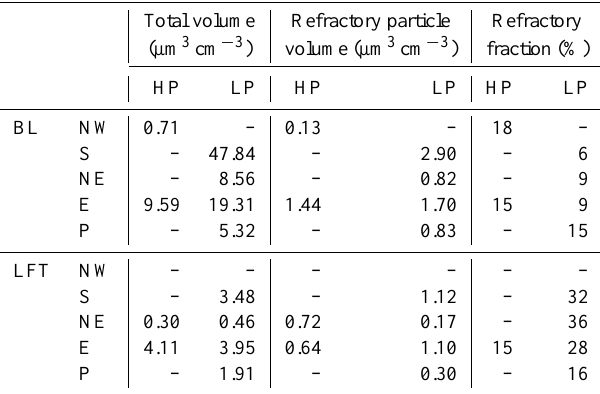
Table 4. Overview of total and refractory particle volume concen- trations (integrated from the volume size distribution) and volume fraction of refractory material for the different air mass